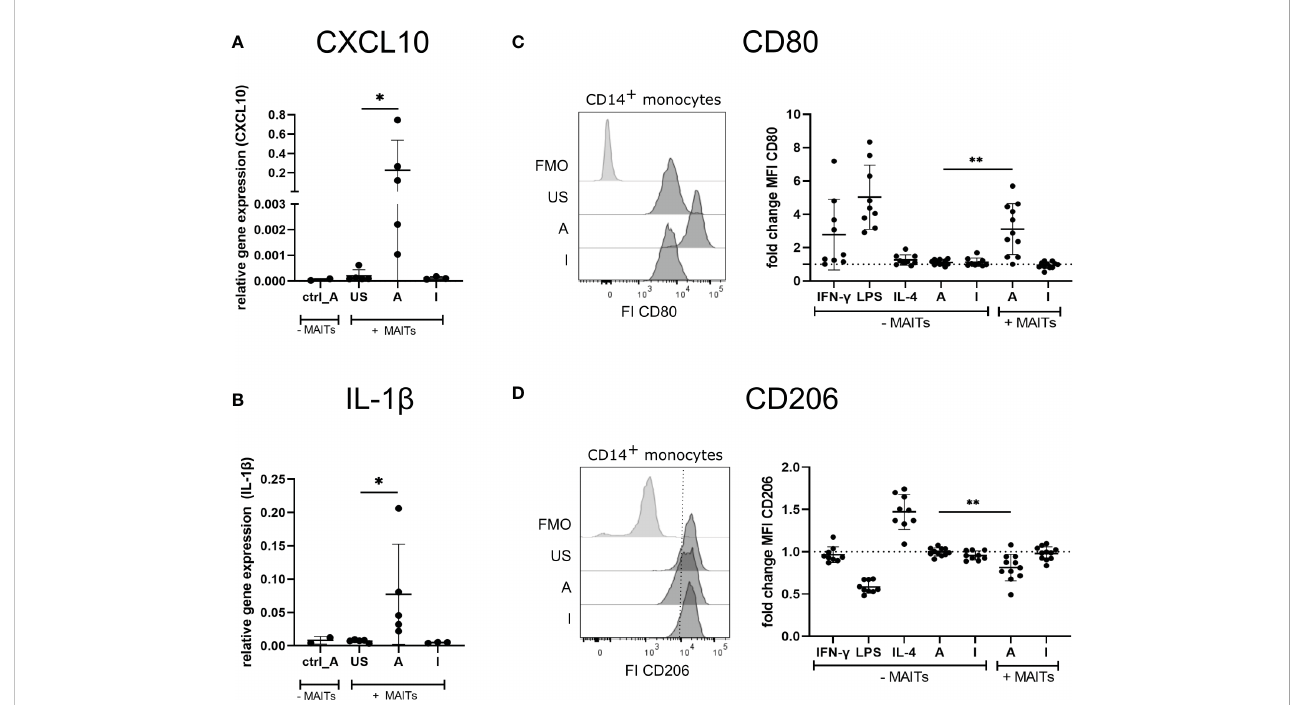
FIGURE 6 5-OP-RU-activated MAIT cells induce an M1-like phenotype of macrophages. (A, B) THP-1 cells were stimulated ± FACS-sorted MAIT for 20 hours with 50 ng/ml 5-OP-RU or Ac-6-FP. Cells were separated by FACS after stimulation. Total RNA was isolated and used for RT-qPCR. Relative gene expression in comparison to GAPDH is shown. Data from two independent experiments from fi ve donors are shown. (C, D) FACS sorted CD14 + monocytes were differentiated into M0 phenotype with M-CSF for 8 days. M0 macrophages were paired with FACS-sorted MAIT cells of the same donor and stimulated for 20 hours with 50 ng/ml 5-OP-RU or Ac-6-FP. Surface expression of CD80 and CD206 on macrophages was determined by fl ow cytometry. (C, D, left) Representative histograms showing MFI of CD80 and CD206 on macrophages incubated in the presence of MAIT cells or showing Fluorescence minus one (FMO) staining. (C, D, right) Fold change in comparison to unstimulated macrophages (± MAIT cells) is shown. Data from four independent experiments from six to nine donors are summarized. (A-D) Asterisks indicate signi fi cant differences determined by Wilcoxon matched-pairs signed rank test; p* < 0.05; p** < 0.01. Horizontal lines indicate mean ± SD. US = unstimulated; A = 50 ng/ml 5-OP-RU; I = 50 ng/ml Ac-6-FP; FI = Fluorescence